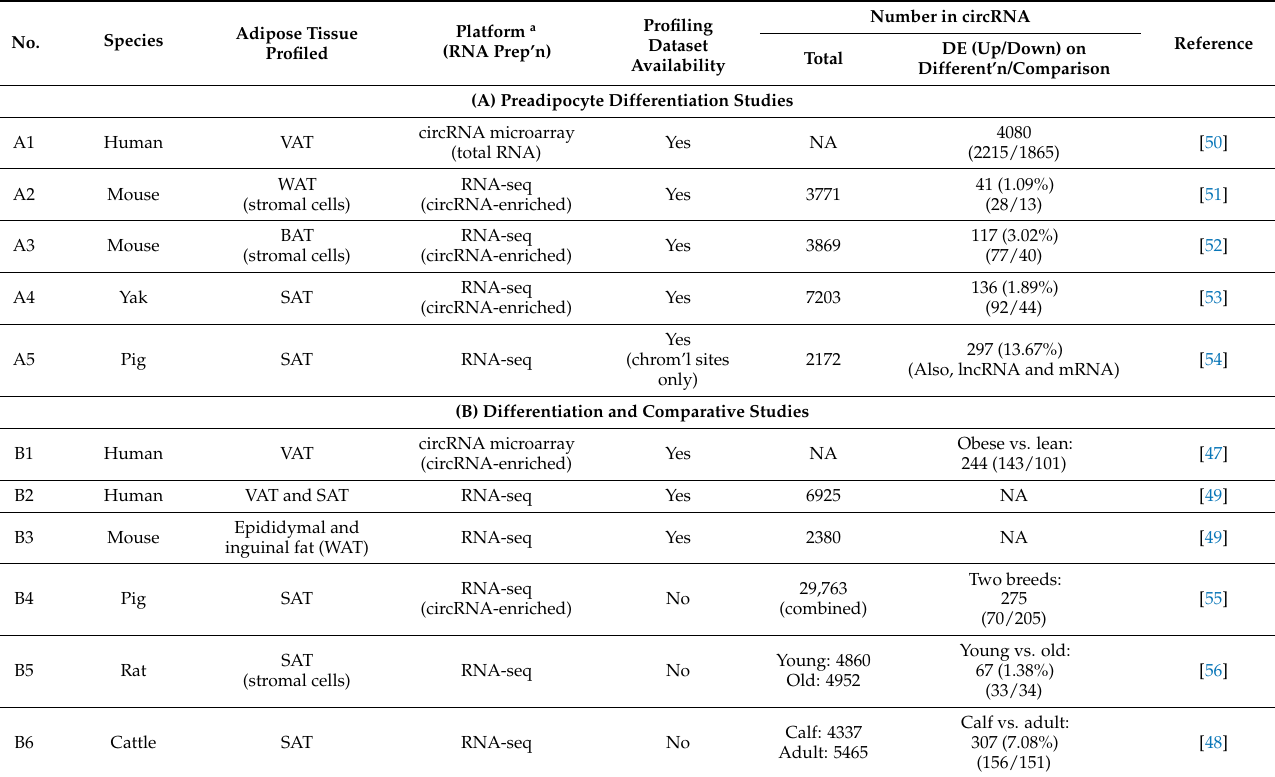
Table 1. Adipocyte circRNA profiling papers and datasets in relation to preadipocyte differentiation and comparative